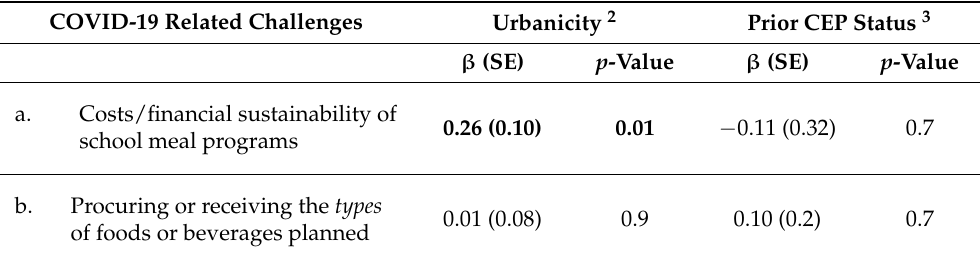
Table 2. Differences in Perceived Challenges due to COVID-19 in Maine by Urbanicity and Prior CEP status 1